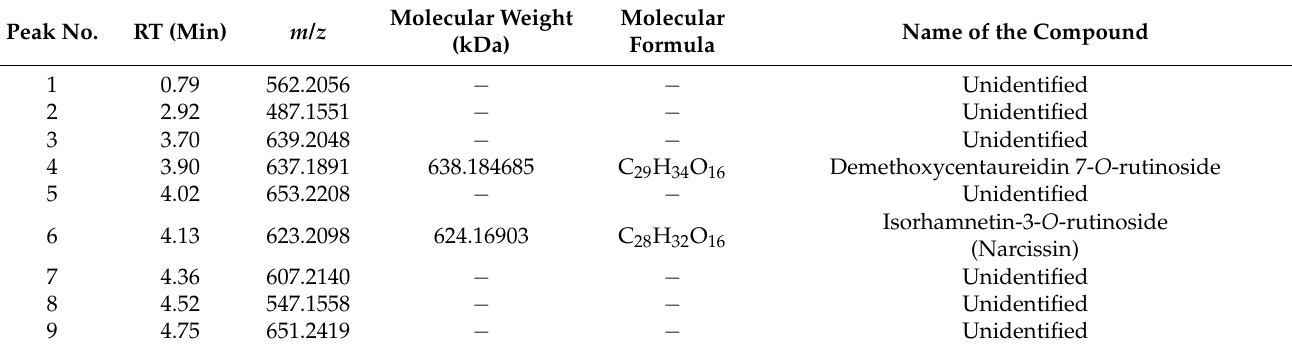
Table 1. The compounds tentatively identified from O. indicum Vent. wild root bark (OIM) extract by UPLC-Q-TOF-MS